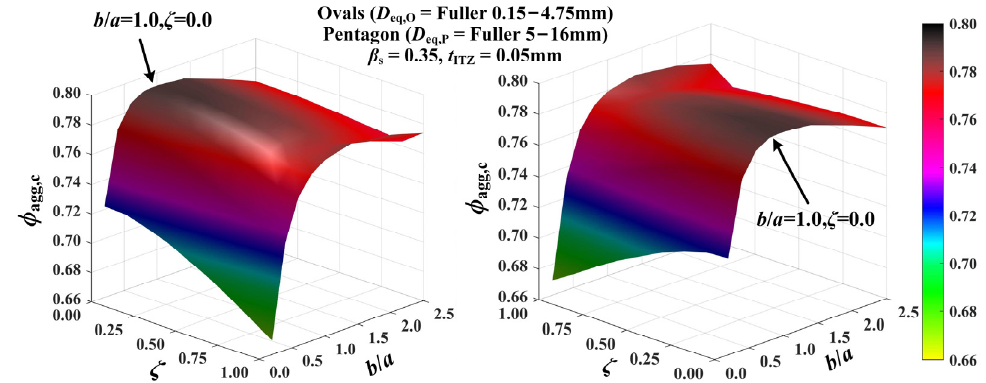
Figure 7. Effect of the geometric shapes of oval particles on the ITZ percolation.